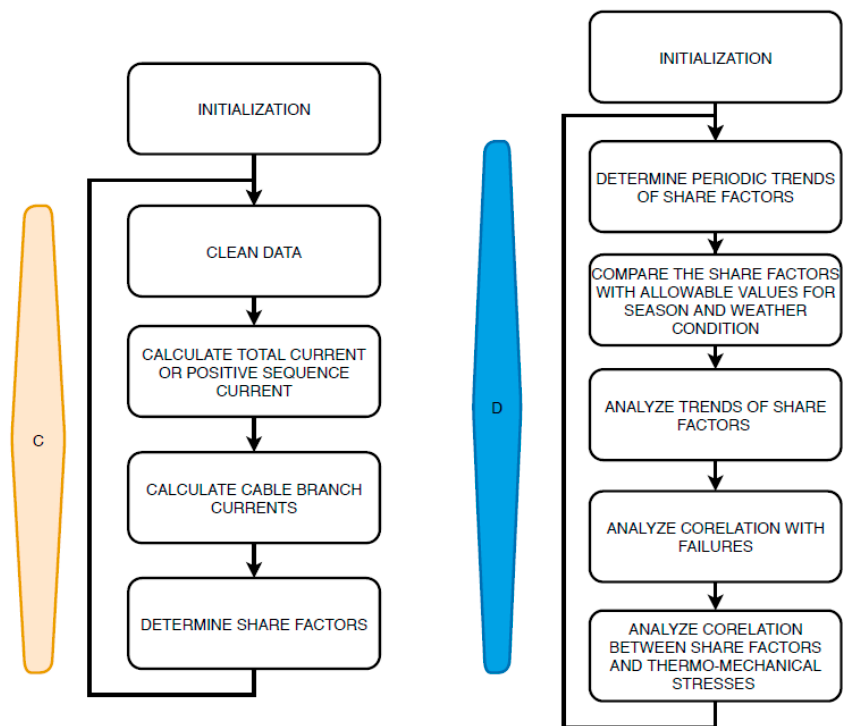
Figure 20. Detailed flowchart presenting data processing and analysis.